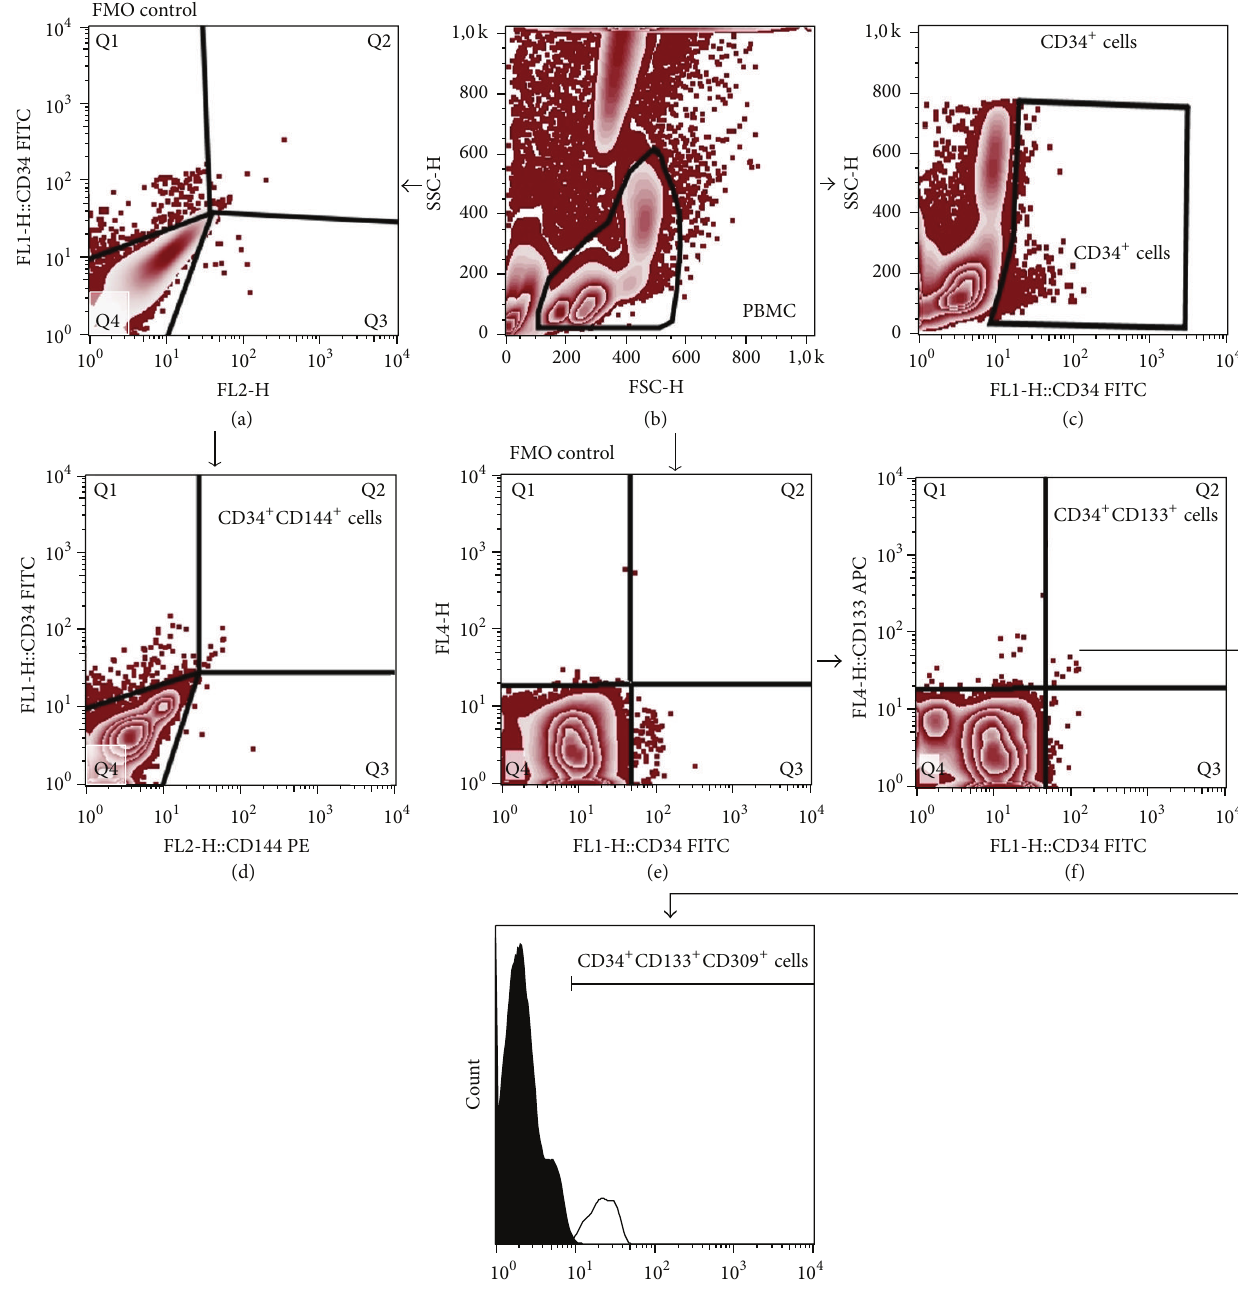
Figure 2: Representative FACS plots demonstrating the gating strategy for CD34 + cells and EPCs. PBMCs were gated based on forward and side scatter (FSC/SSC) plot (b). CD34 + cells were gated on CD34/SSC plot (c). CD34 + CD144 + cells (upper right quadrant, Q2) were gated based on CD34/CD144 dot plot (d). FMO control was used to set the gates (a). In order to determine CD34 + CD144 + CD309 + cell numbers, the PBMC events were displayed on the basis of FMO control sample (e) and gates were set to exclude the random noise. Next, the gates were visualized on CD34/CD133 plot (f) and CD34 + CD133 + cells were gated (upper right quadrant, Q2). Finally, CD34 + CD133 + CD309 + cells subsets were gated on histogram plot (g) (black peak, control; grey peak, positive